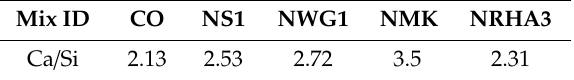
Table 6. Ca / Si ratio of di ff erent concrete mixes.